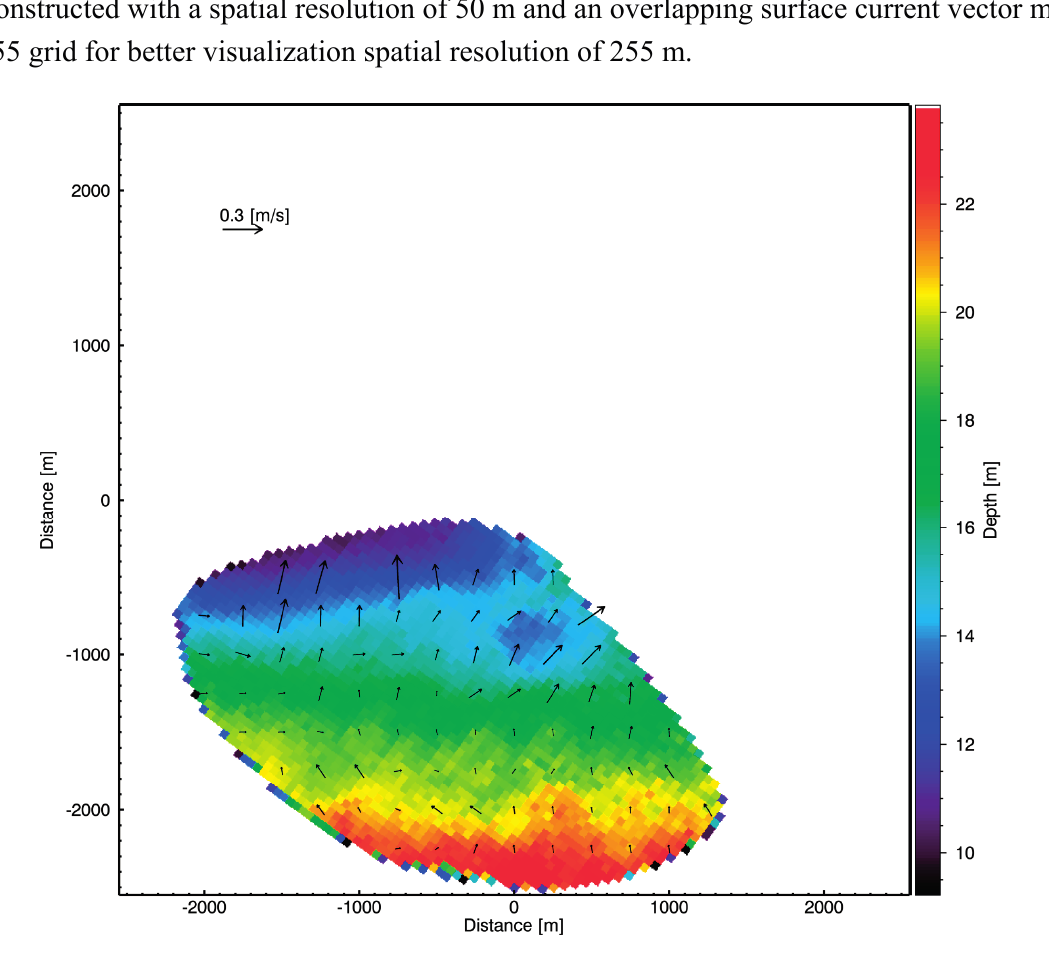
Figure 10. Radar bathymetry map with spatial resolution of 50 m, and the surface current vector map with a 255 m spatial